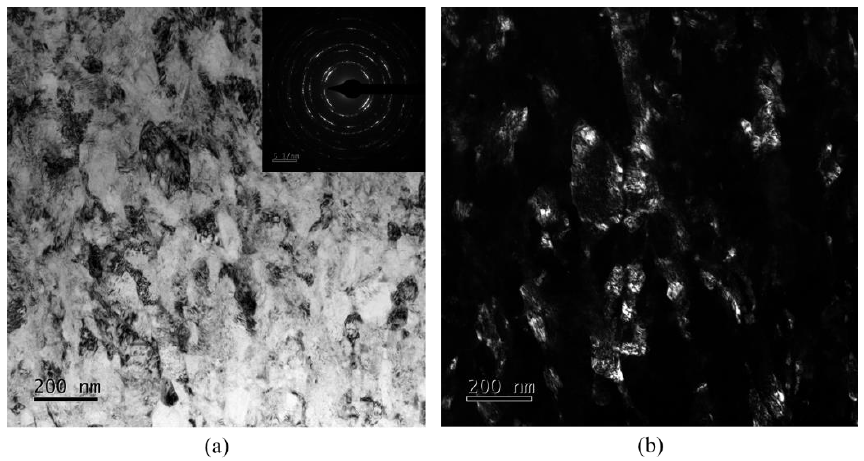
Figure 24. TEM images of the LRP of FeNiCoCr HEA annealed at 850 °C, v = 1052 m/s: ( a ) Bright-field TEM image of the microstructure of the front part; ( b ) corresponding dark-field TEM image of ( a ).